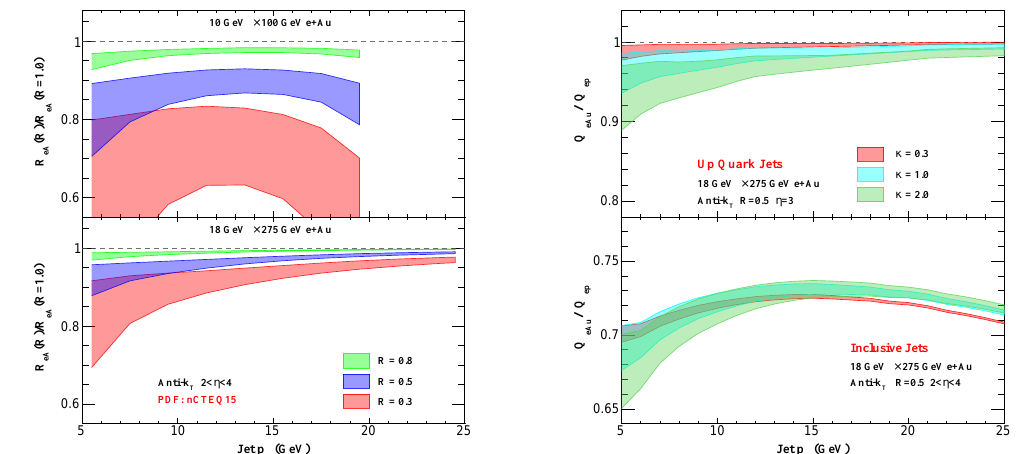
Figure 2: Left: ratio of jet cross section modifications for different radii ( R ) / R ( R = 1.0 ) in 10 × 100 GeV (upper) and 18 × 275 GeV (lower) e + Au R eA eA collisions, where the smaller jet radius is R = 0.3, 0.5, and 0.8, and the jet rapidity interval is 2 < η < 4. Right: modifications of the jet charge in e + Au collisions. The upper panel is the modification for up-quark jet with η = 3 in the lab frame. The lower panel is the results for inclusive jet with 2 < η < 4 in 18 × 275 GeV e + Au